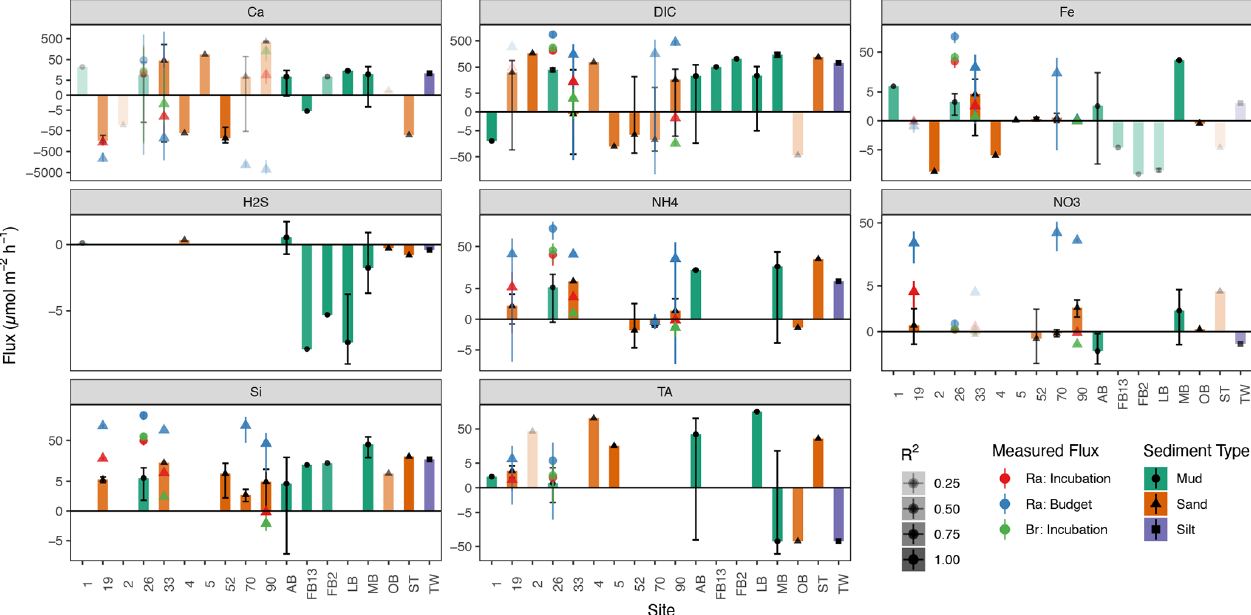
Figure 4. Sediment–water fluxes (µmolm − 2 h − 1 ) for all sites in the Baltic (sites AB–TW) and North seas (sites 1–90), derived from PRO- FILE modeling (colored bars), with incubation and decay rates for comparison from the North Sea only (colored points). Bars with greater transparency indicate PROFILE flux results of lower confidence ( R 2 ). The error bars in this figure represent the standard deviation of fluxes modeled from replicate cores at each